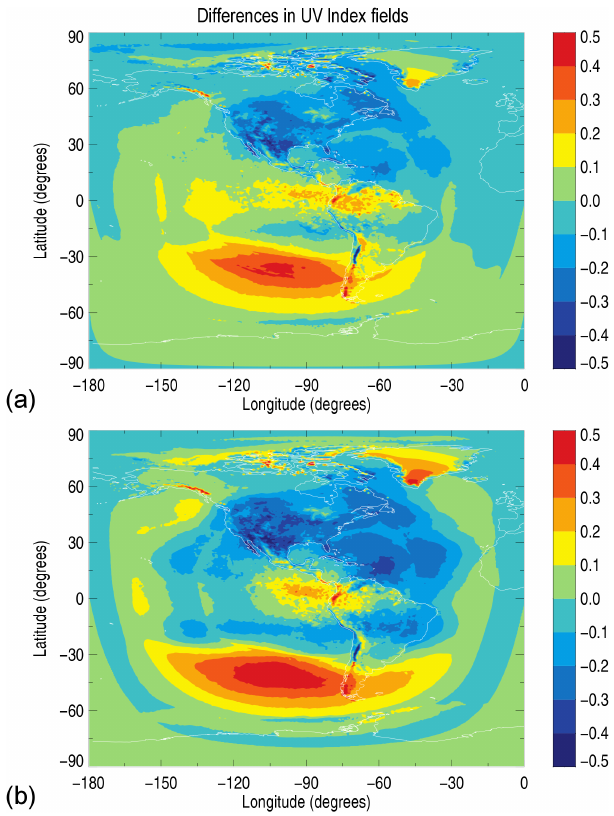
Figure 9. Differences in the UV Index field produced from the scaled and weighted GEM irradiances compared to the field pro- duced using the high-resolution Cloud-J irradiances for the integra- tion approach and linear fit, representing plots (a) and (b) , respec- tively.